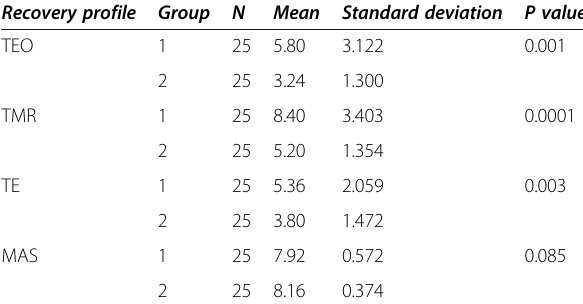
Table 2 Comparison of recovery profile between two groups (group 1 = control group, group 2 = BIS group) Recovery profile Group